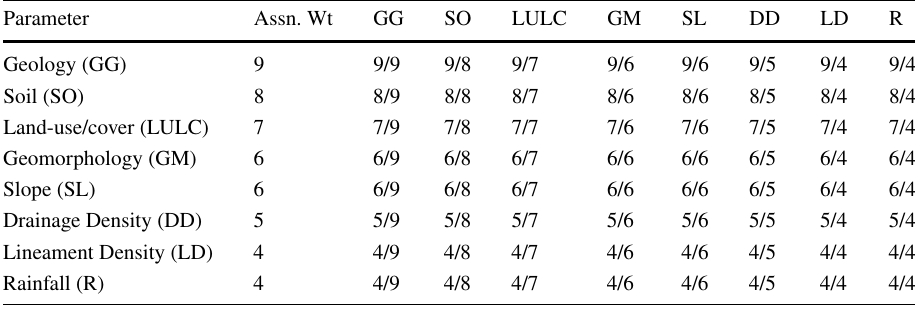
Table 5 Weight assigned and pairwise comparison matrix of eight thematic layers influencing recharge in the study area